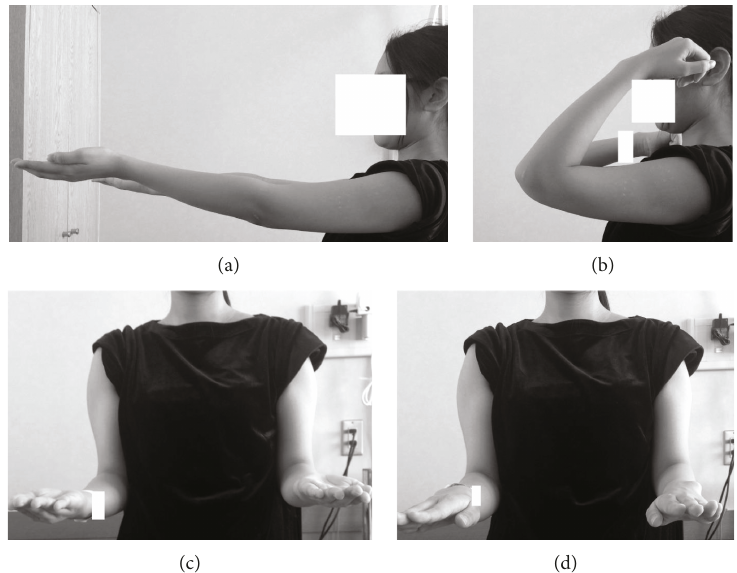
Figure 1: Preoperative ranges of motion. Elbow extension (a) and fl exion (b). Forearm supination (c) and pronation (d).